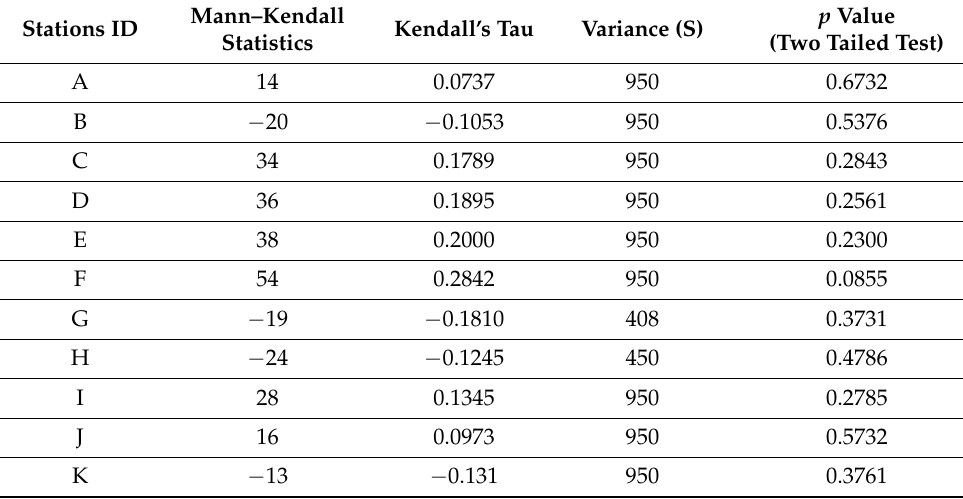
Table 6. Mann–Kendall test results for Precipitation for Meteorological